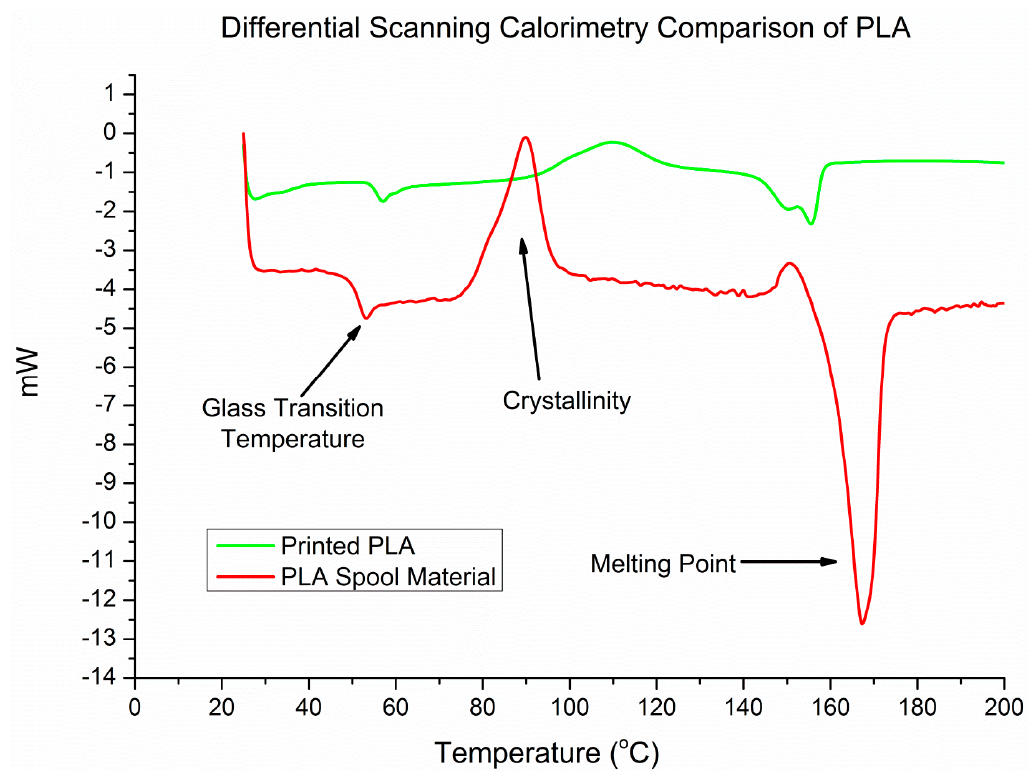
Figure 8. Differential scanning calorimetry (DSC) comparison of PLA spool material and printed PLA.